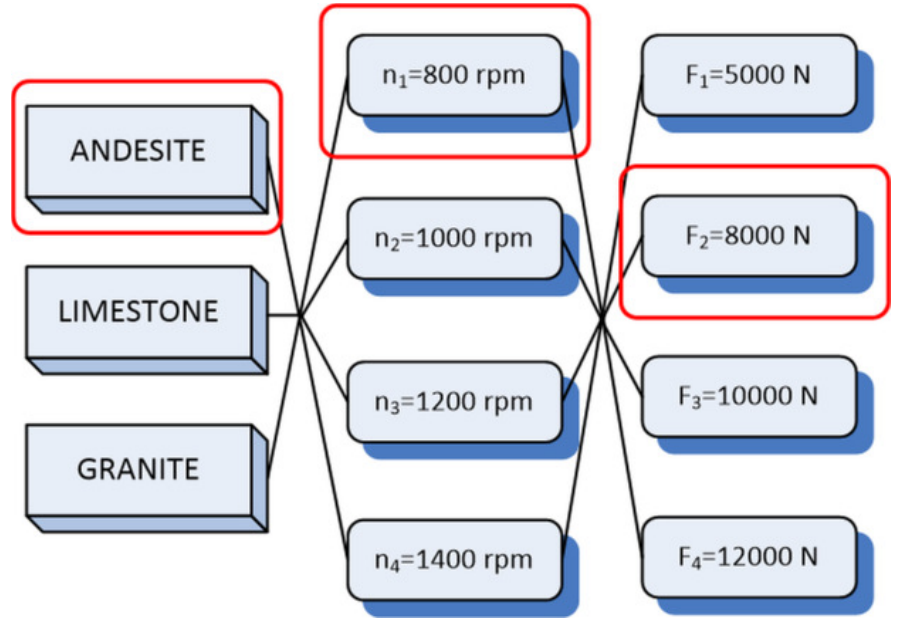
Figure 6. Operating mode